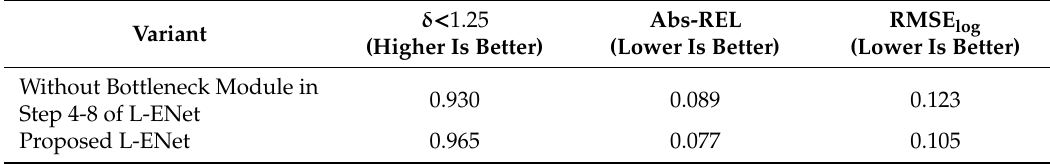
Table 5. Evaluation results of bottleneck module using the KITTI dataset.